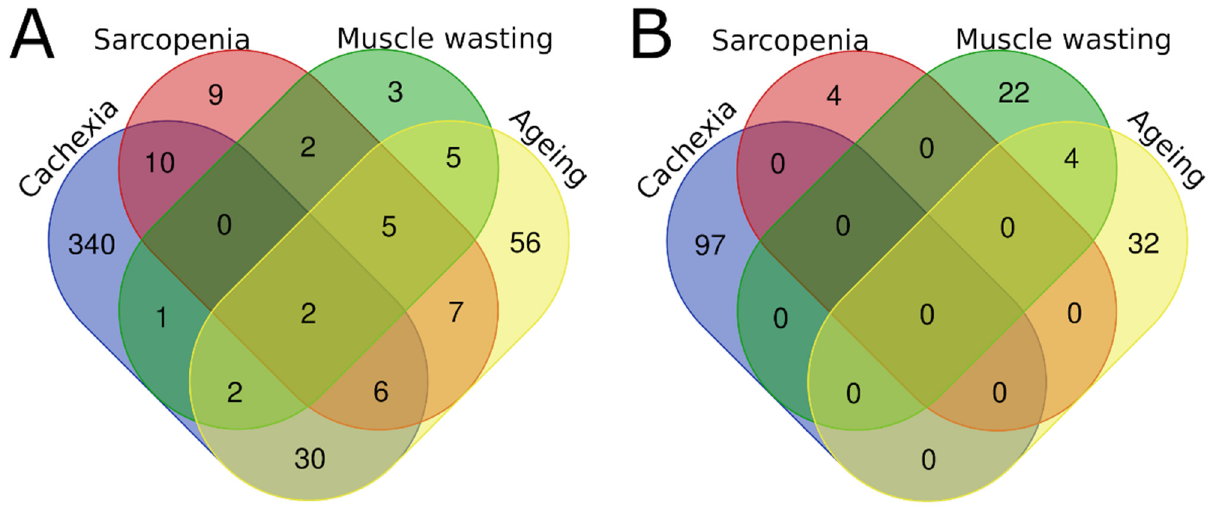
Figure 1. Venn diagram representing the number of overlapping proteins across all four muscle- wasting conditions identified in ( A ) tissue samples from 15 proteomics studies and in ( B ) biofluid samples from 10 proteomics studies.